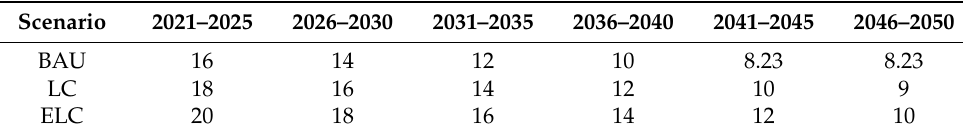
Table 2. The setting of Beijing’s energy intensity decline (unit: %).